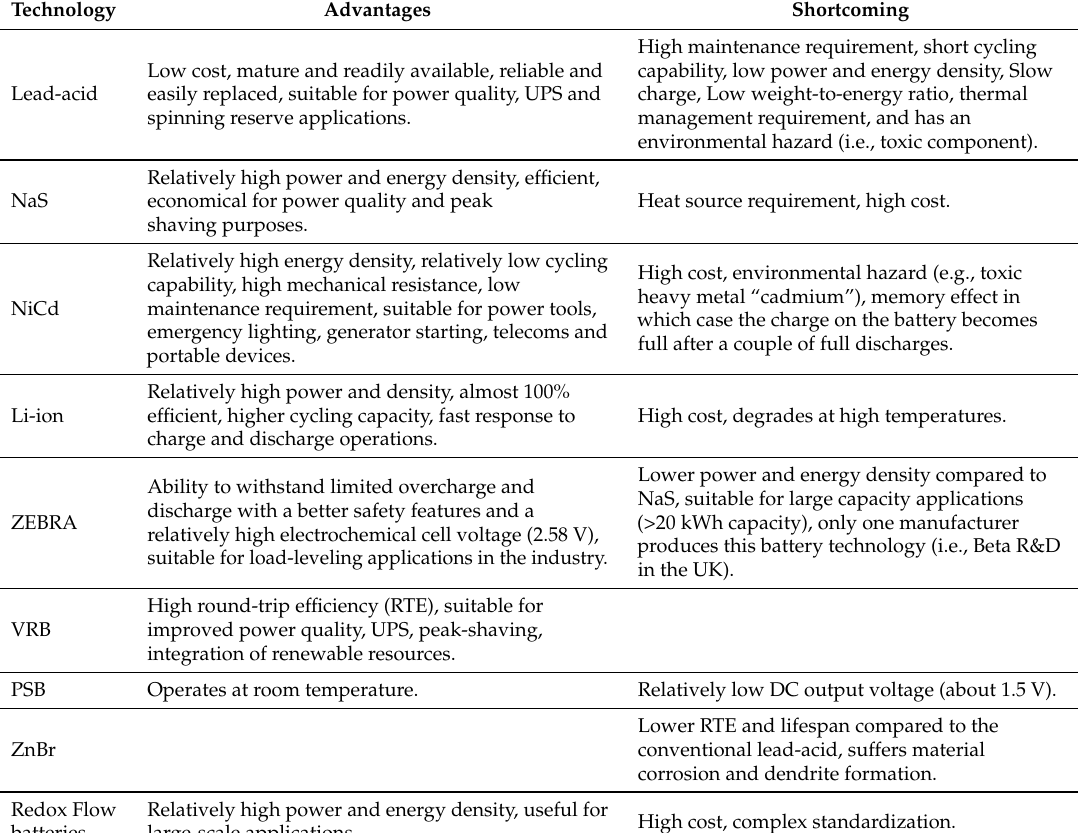
Table 3. Comparison of the advantages and the shortcomings of the technologies